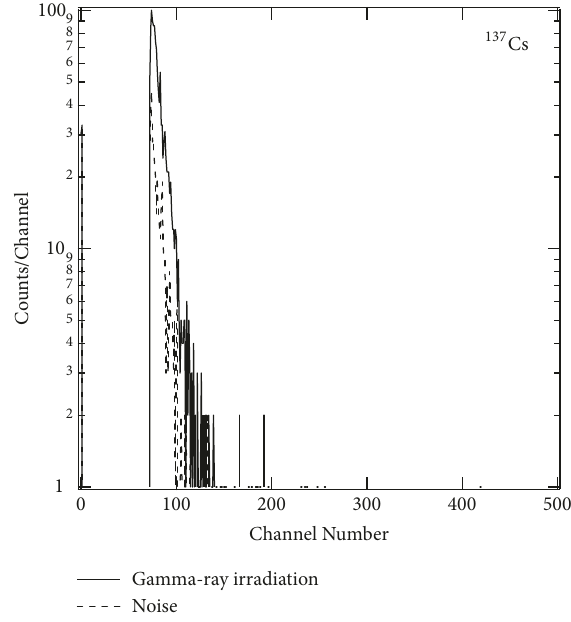
Figure 11: 137 Cs gamma-ray energy spectrum obtained from the SbI 3